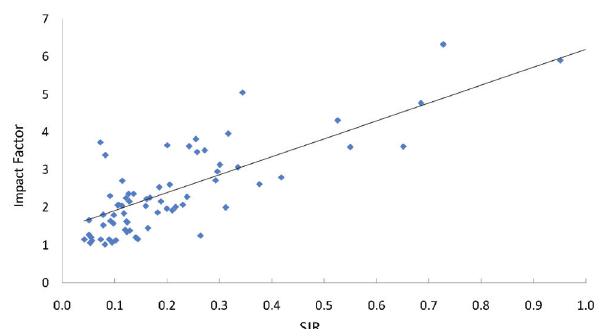
Figure 2 - The correlation between ISI impact Factor and Scimago Journal Ranking - SJR (correlation coeficient = 0.884; p <